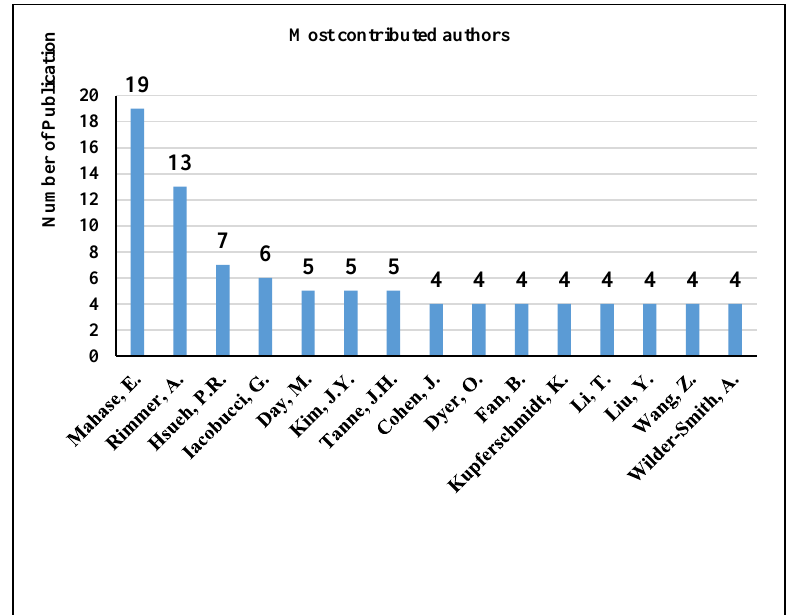
Figure 2. Most contributing authors in the field of